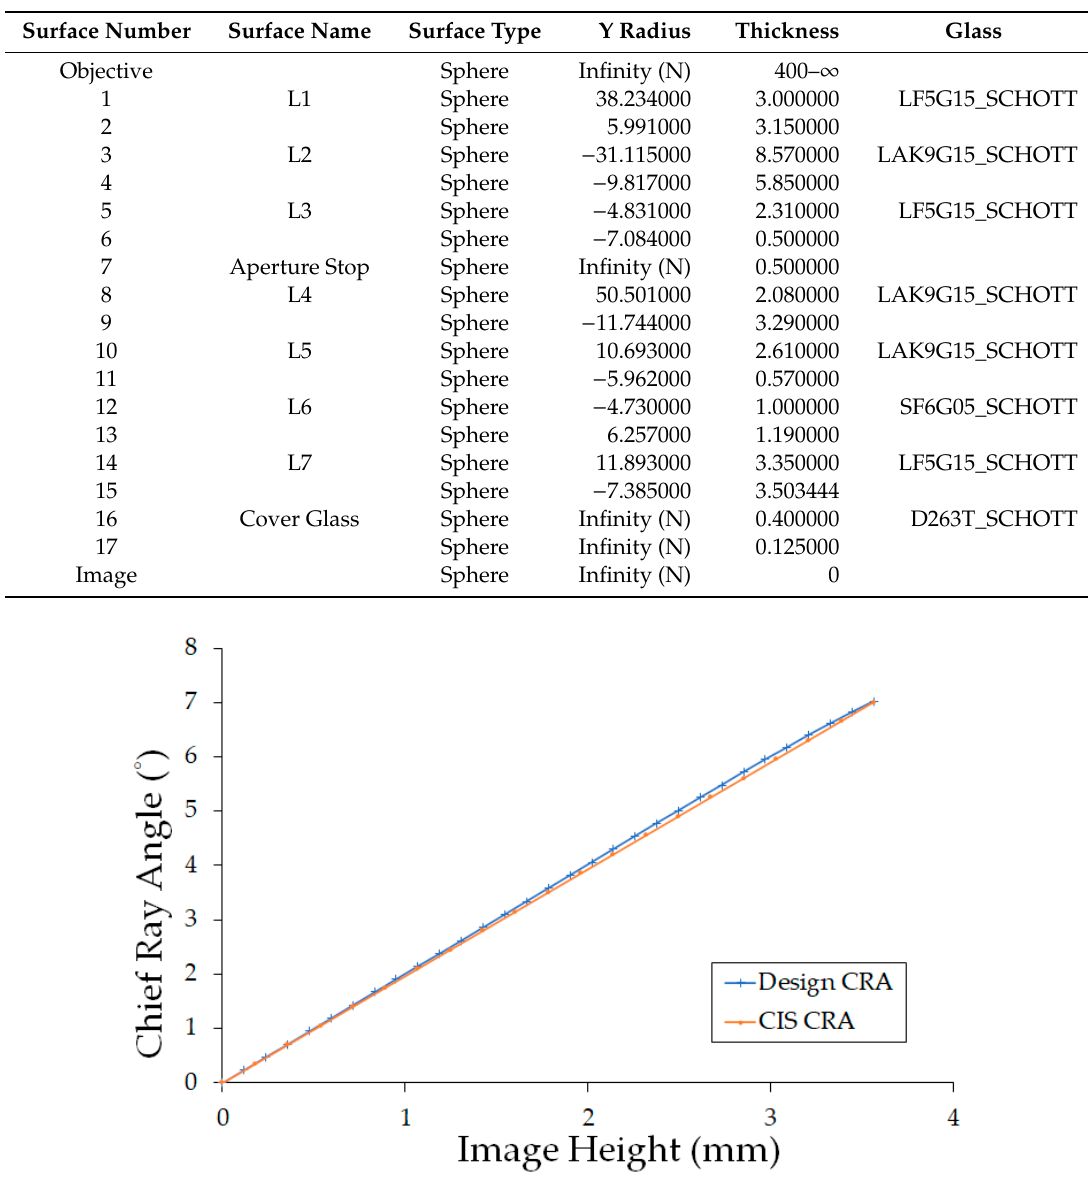
Table 3. Lens data of the docking camera lens. Figure 2. Optical layout of the docking camera lens.